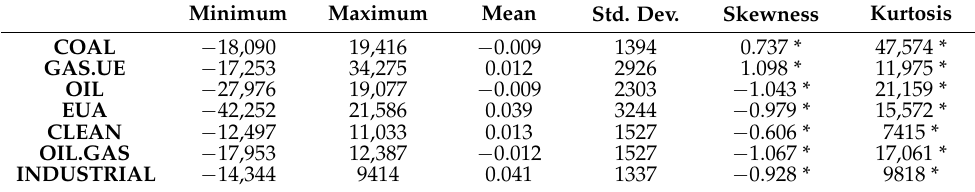
Table 1. Descriptive analysis of the daily returns of the seven series. Minimum Maximum Mean Std.